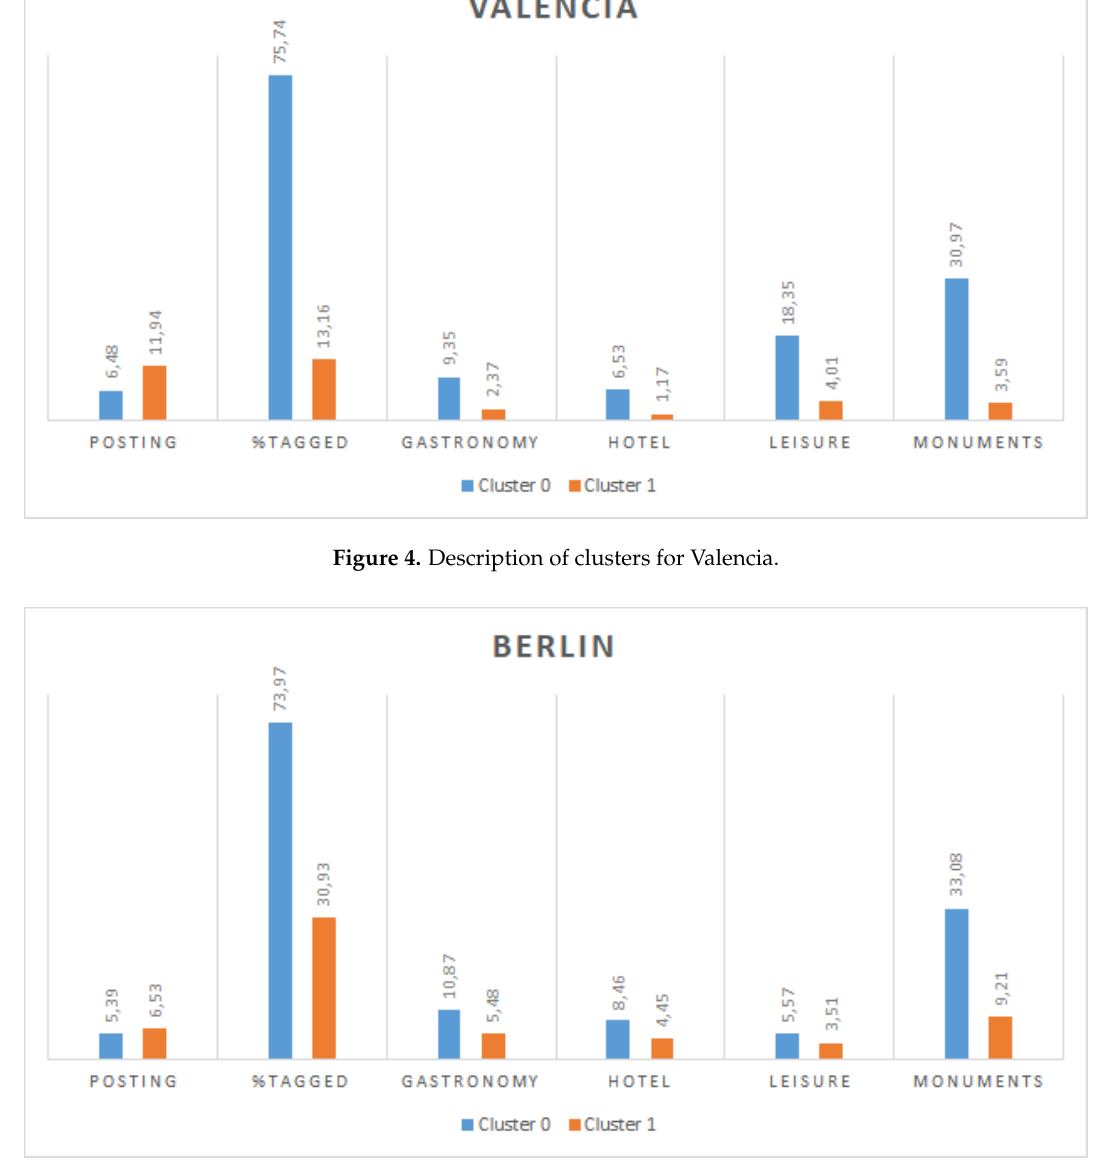
Figure 5. Description of clusters for